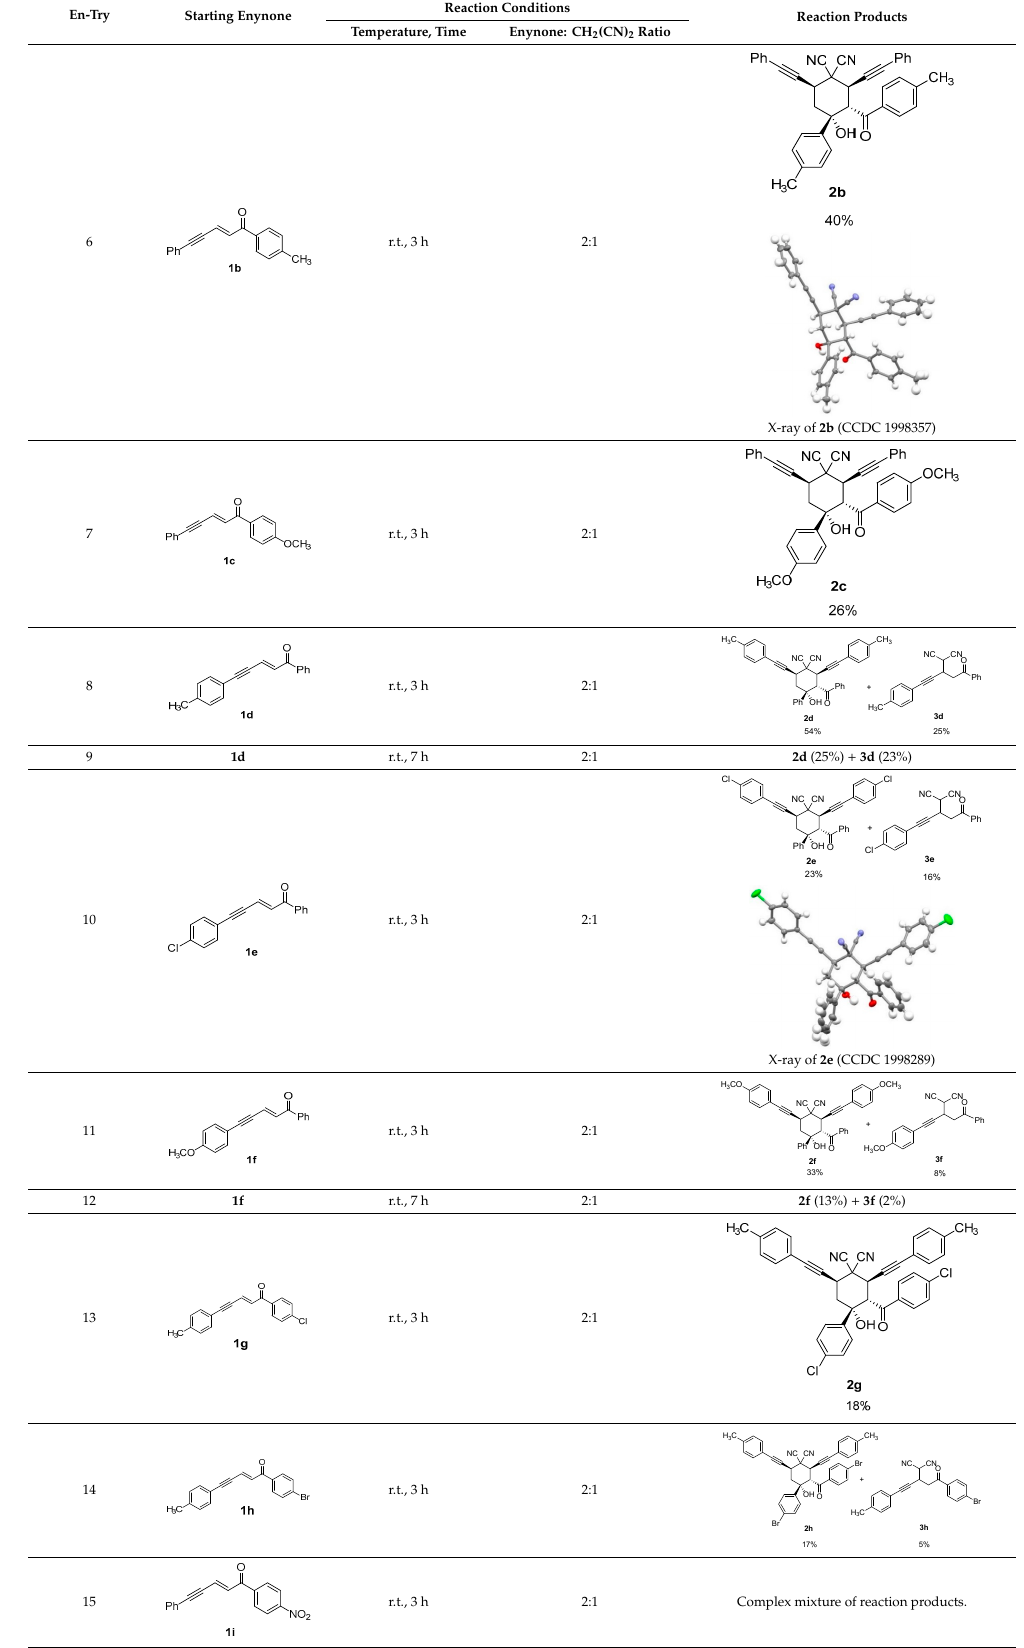
Complex mixture of reaction products.